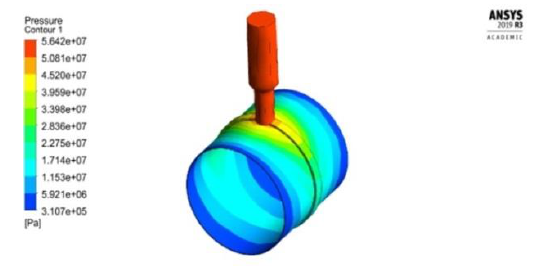
Fig. 7. Pressure distribution inside oil film 1